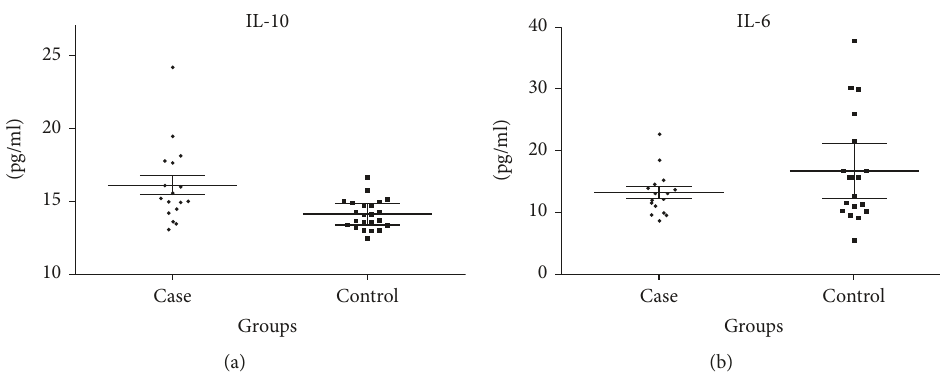
Figure 1: Interleukin concentrations between the groups. (a) IL-10 serum levels in DS (16.10 pg/ml) and control (14.09 pg/ml) groups. Mann – Whitney test ( P = 0 002 ). (b) IL-6 serum levels in DS (13.03pg/ml) and control (15.69 pg/ml) groups. Mann – Whitney test ( P = 0 69 ). The bars represent median with interquartile variation (25th percentile and 75th